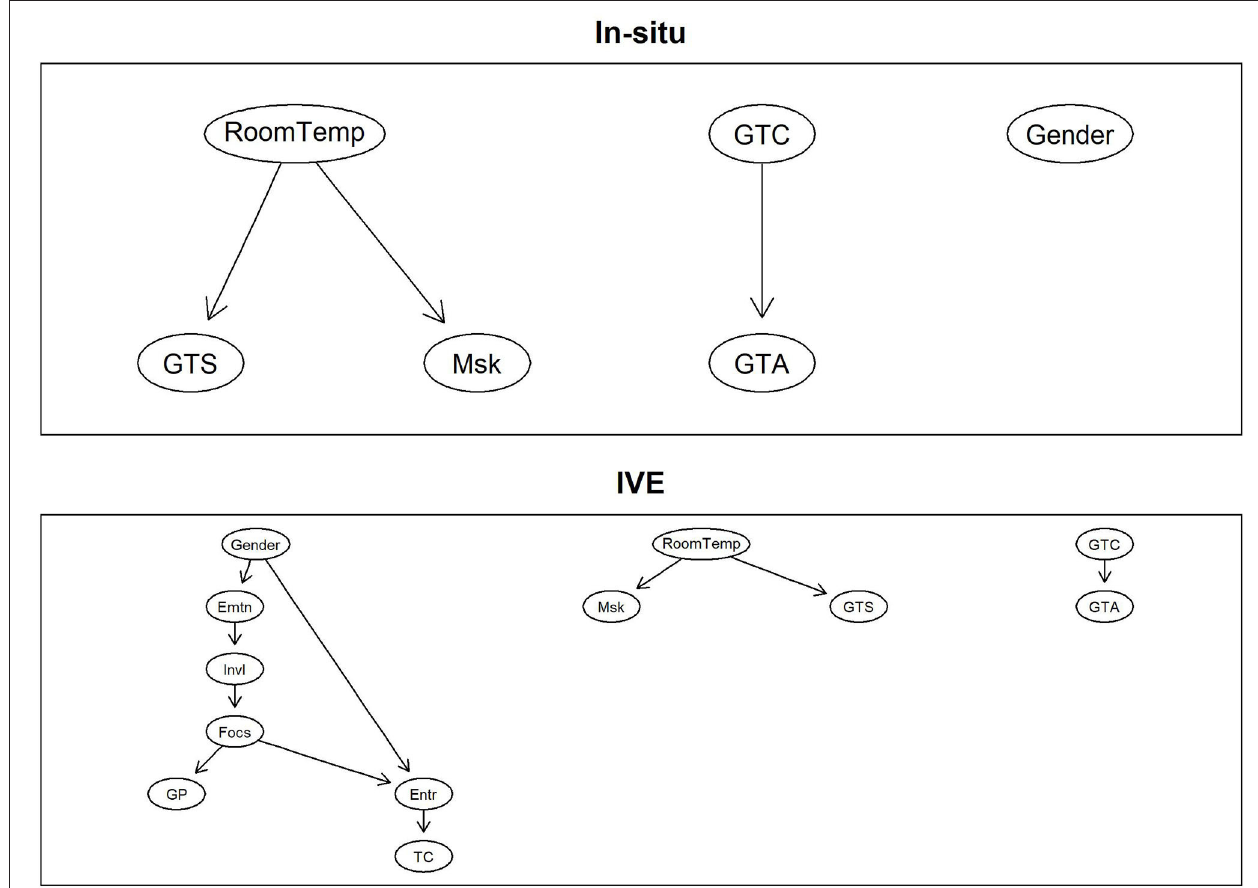
FIGURE 8 | SCM for thermal states in in-situ (top) and IVE (bottom) conditions.